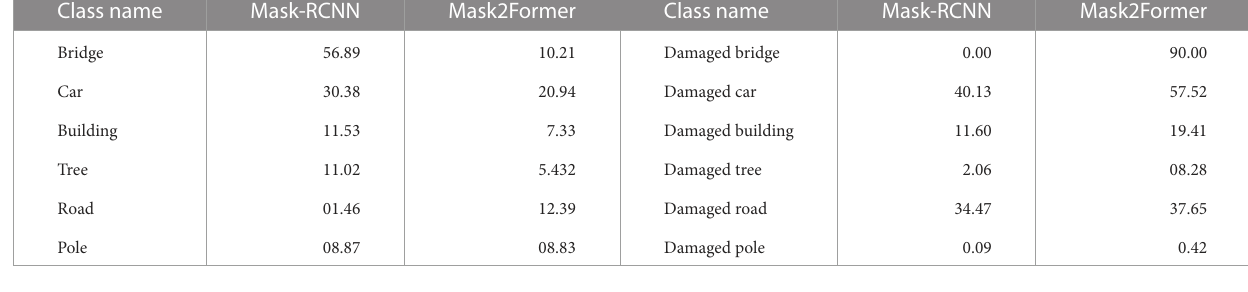
TABLE2 Class-wiseAPforfine-tunedMask-RCNNandMask2Formeroverthetestset.